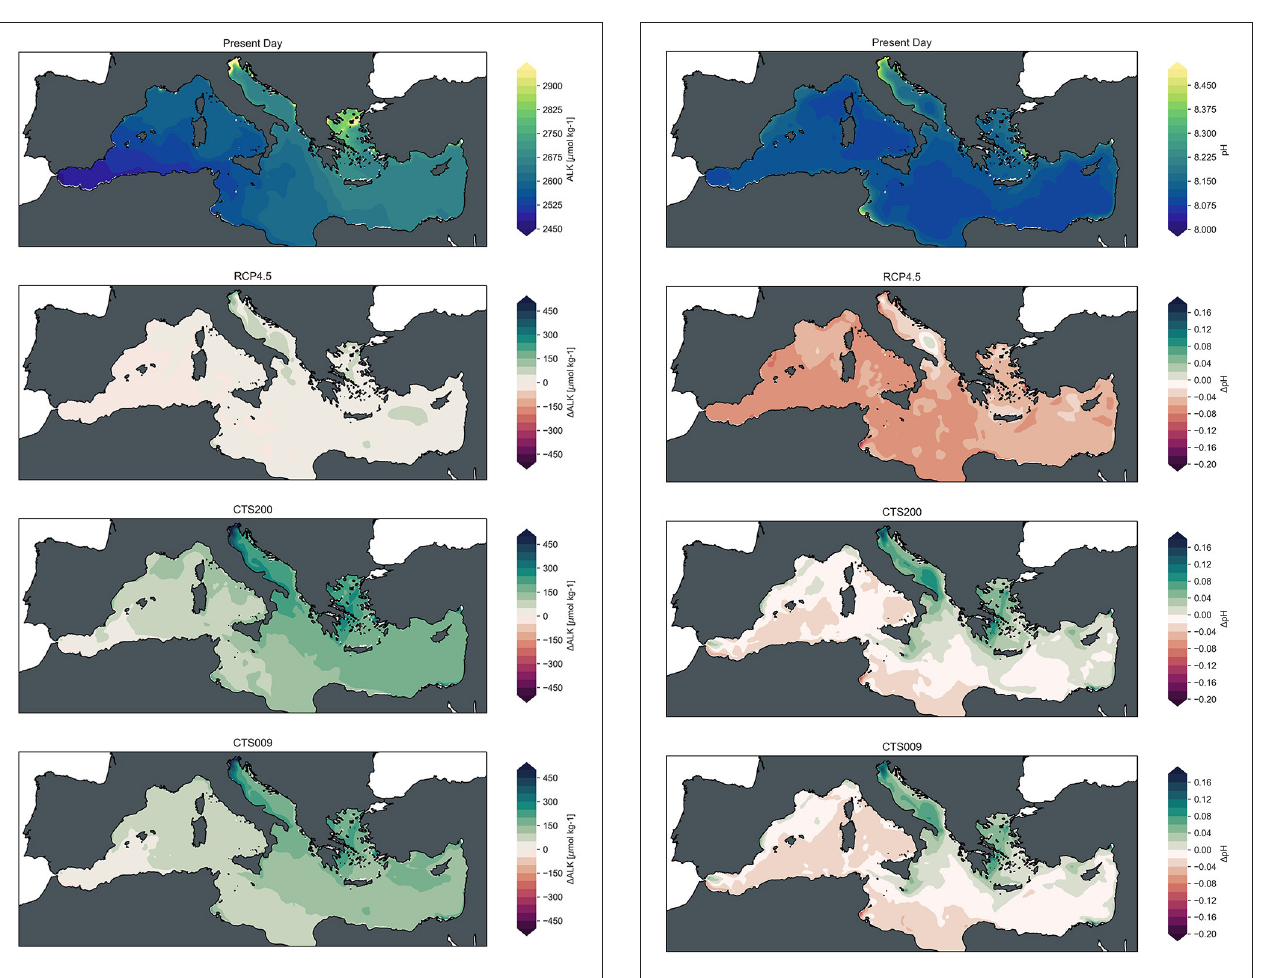
FIGURE 5 | Fields of mean surface pH for present day (2016–2020) and changes of mean fields at mid-century (2046–2050) with respect to present day conditions for RCP4.5 baseline scenario, CTS200 scenario and CTS009 scenario (from top to